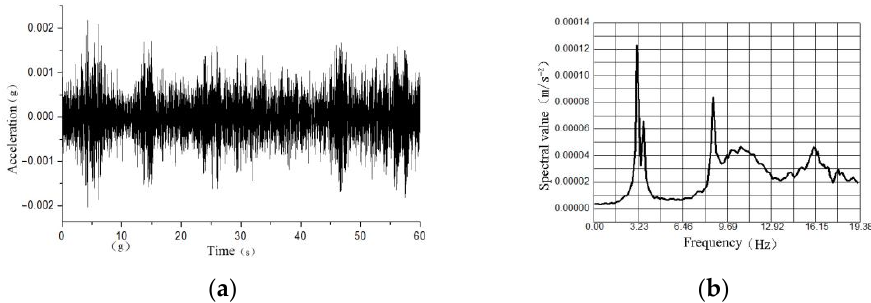
Figure 18. ( a )Acceleration time-history curve (Y direction); ( b ) The corresponding spectrum.